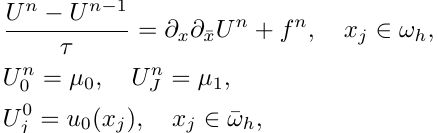
In Table 1 values of (cid:107) ( I + τA h, 1 ) − 1 ψ n time and space steps. Numerical experiments are done for two relations τ = h and τ = 50 h 2 of discrete steps. The experimental convergence rates p are